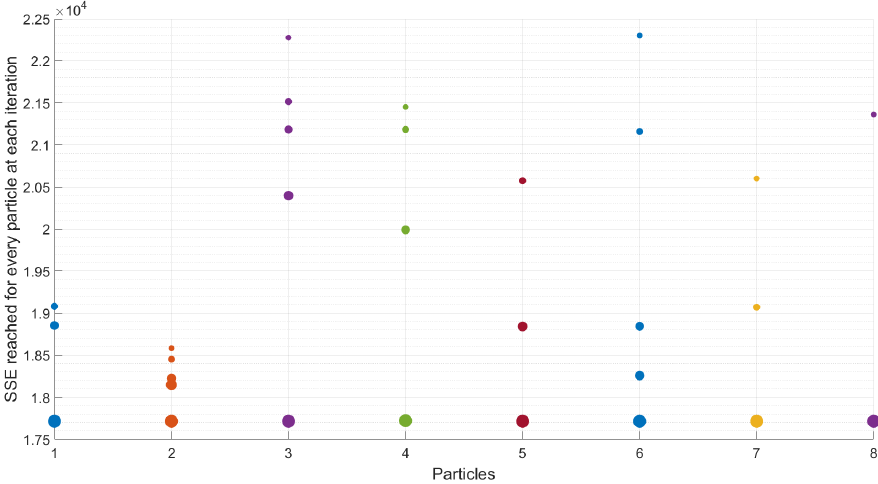
Figure 10. Process of optimization performed for each particle.